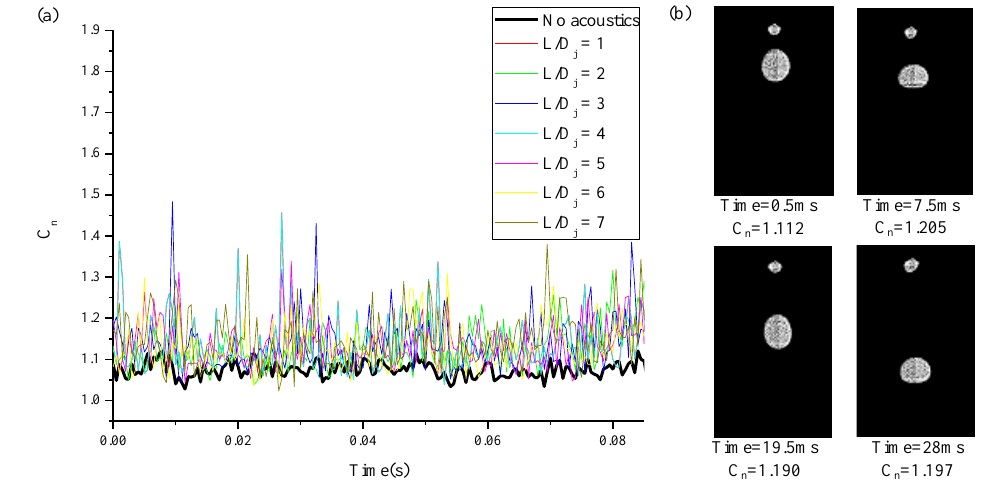
Figure 7. Variation of C n with time: ( a ) cases with and without acoustics at different cavity lengths; ( b ) picture examples of L / D j = 1.